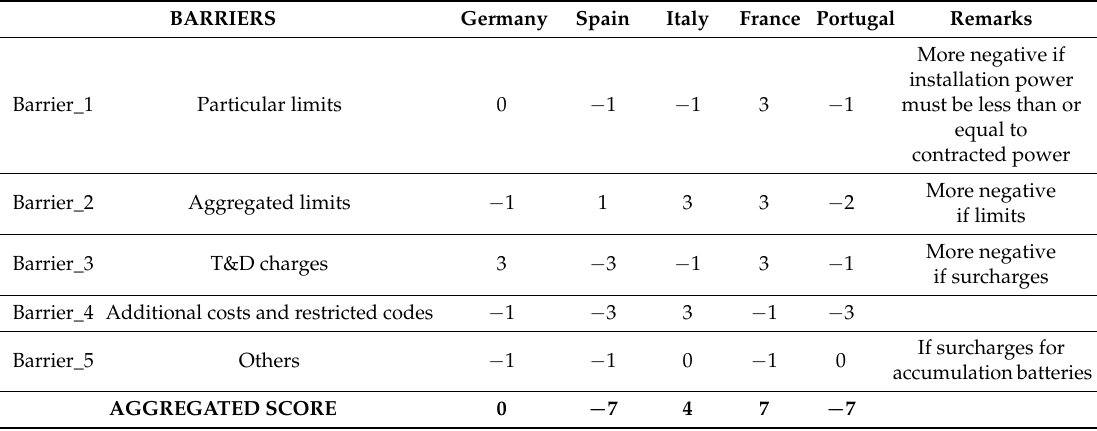
Table 2. Regulation impact on the set of barriers for self-consumption (own